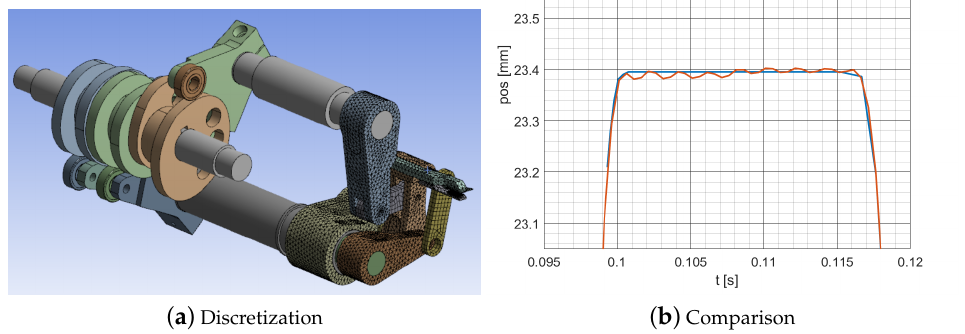
Figure 6. ( a ) FEM discretization of the five-bar linkage employed for the elastodinamic simulations, ( b ) comparison between rigid and flexible simulations at the grasp